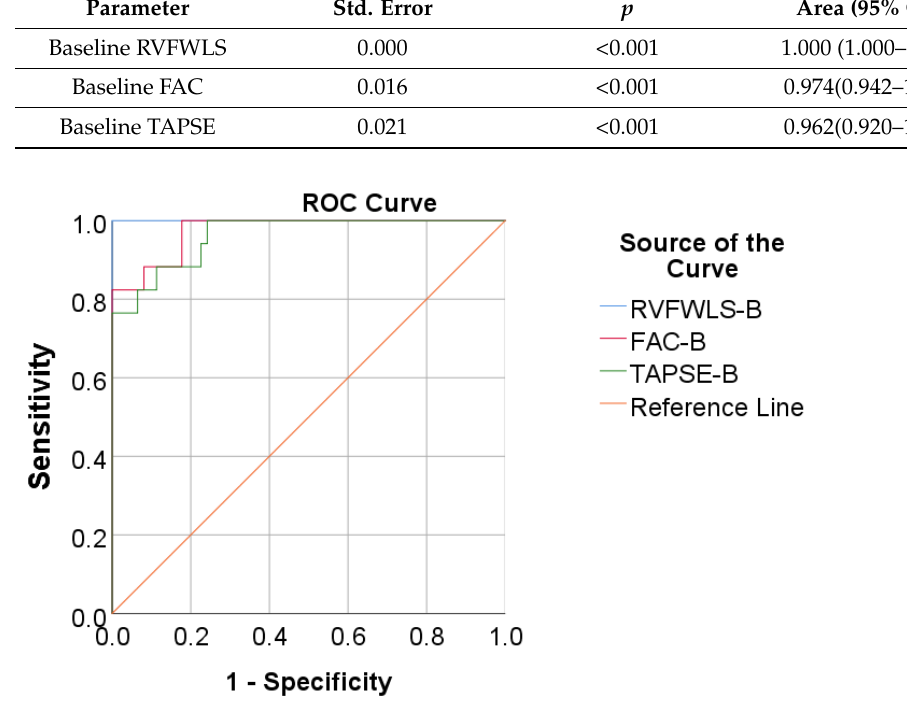
Figure 7. ROC curve using RVFWLS, FAC, and TAPSE baseline values for the prediction of mor- tality.